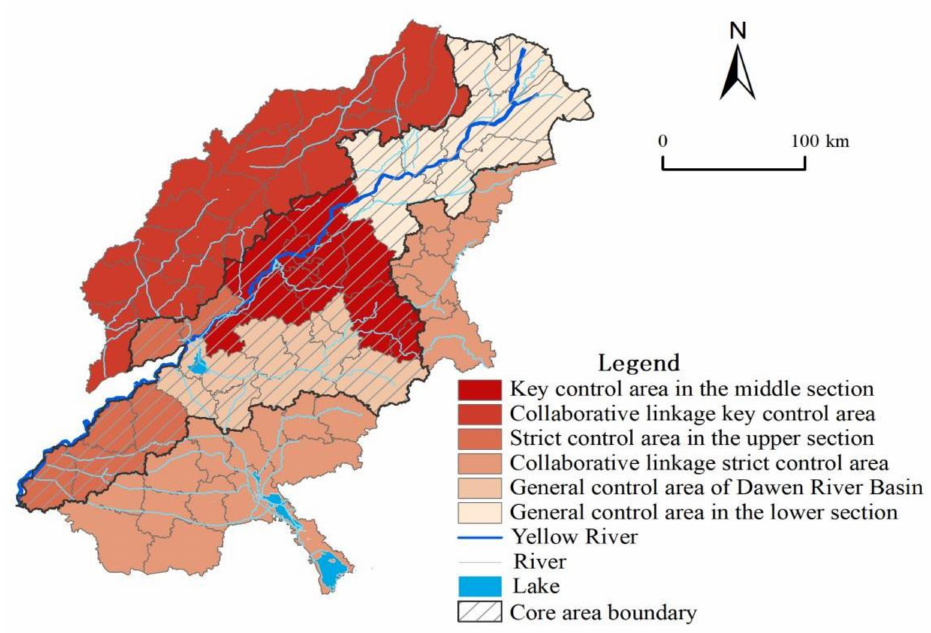
Figure 10. Spatial control distribution of LER in typical areas of the Yellow River